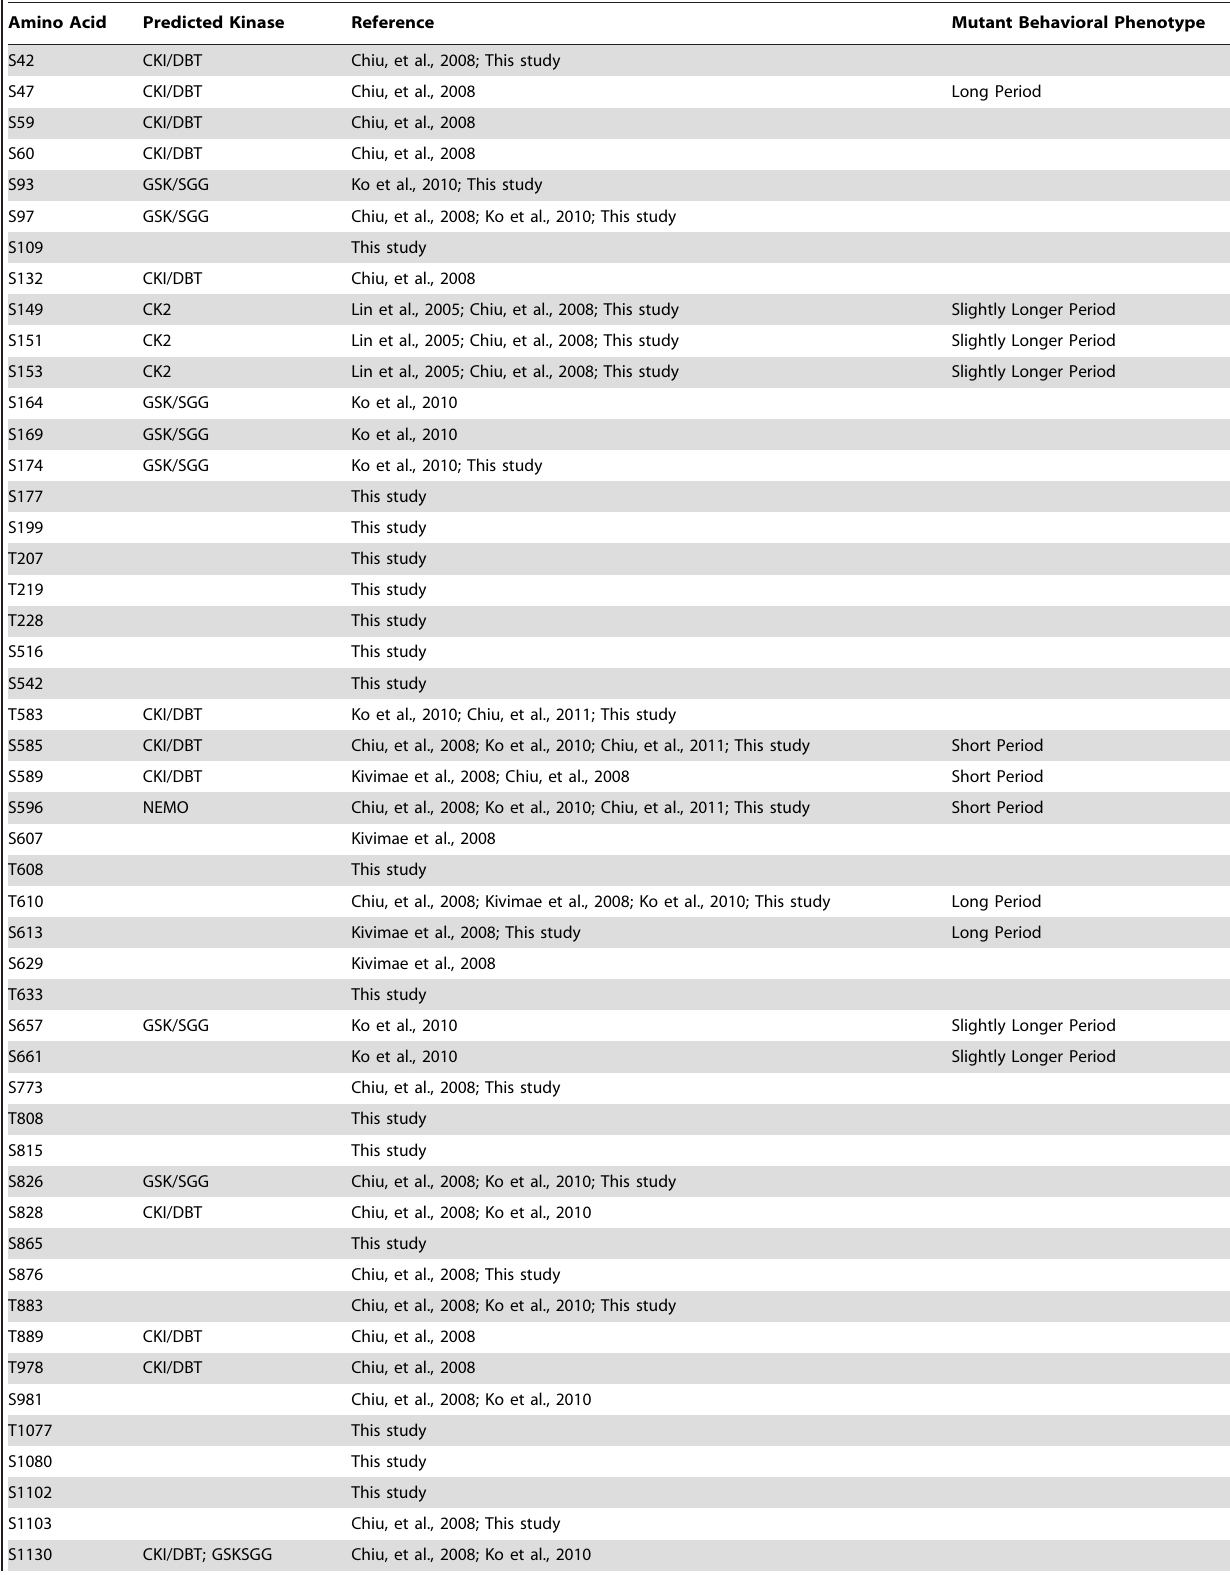
Amino Acid Predicted